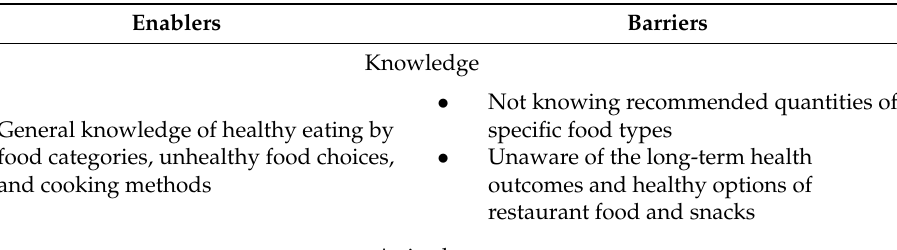
Table 6. Summary of key KAP enablers and barriers to healthy eating in